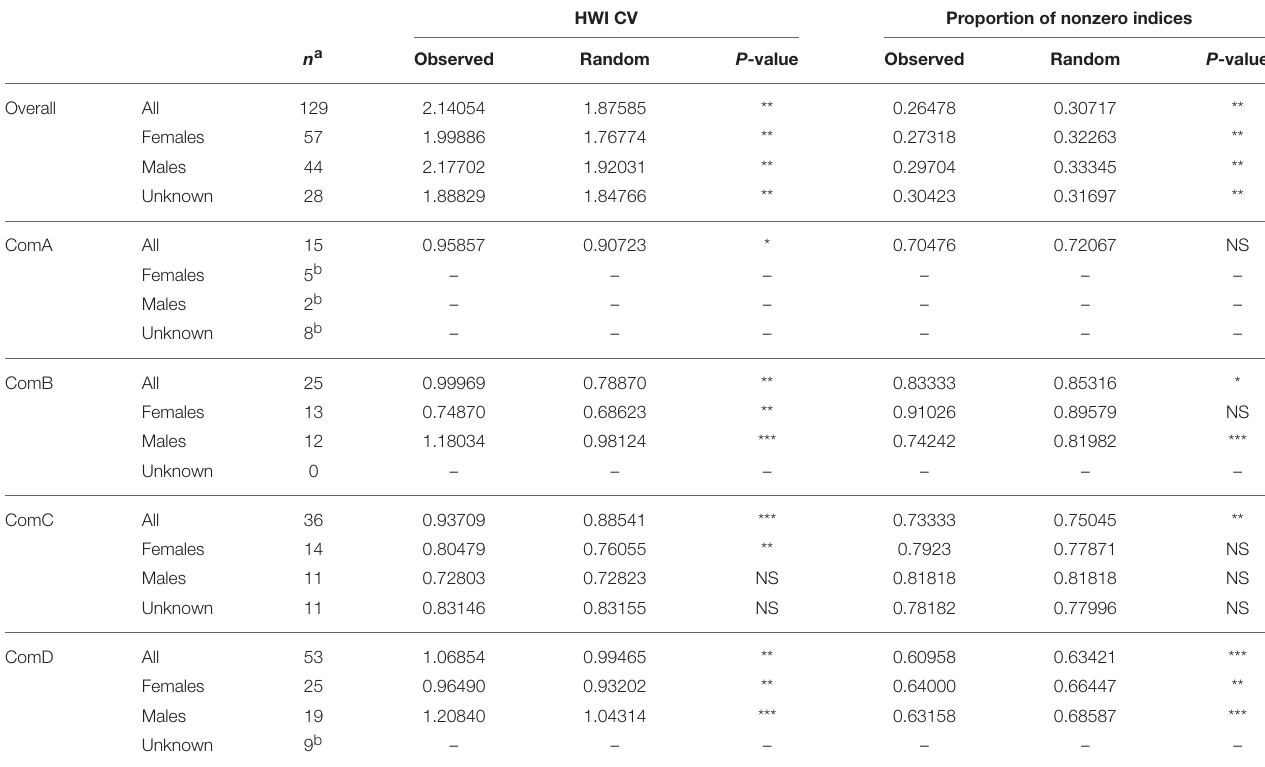
TABLE 5 | Sex class (female, male, unknown sex) permutation tests for preferred (HWI CV) and avoided (proportion of non-zero indices) associations for the population overall and per